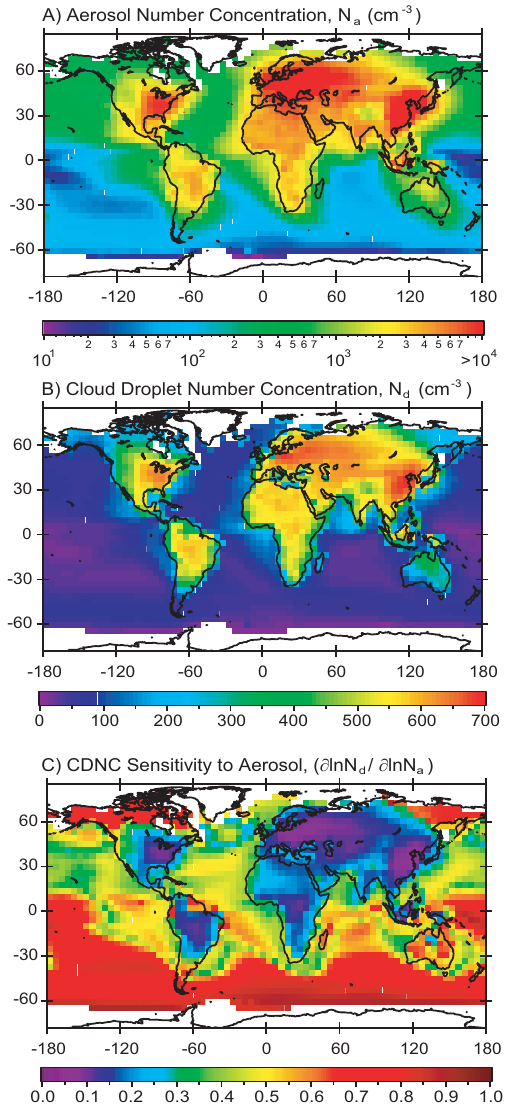
0.0 0.1 0.2 0.3 0.4 0.5 0.6 0.7 0.8 0.9 Fig. 1. Simulated global spatial distribution of the annual mean N a (A) , N d (B) and logarithmic sensitivity of N d to N a (C) .